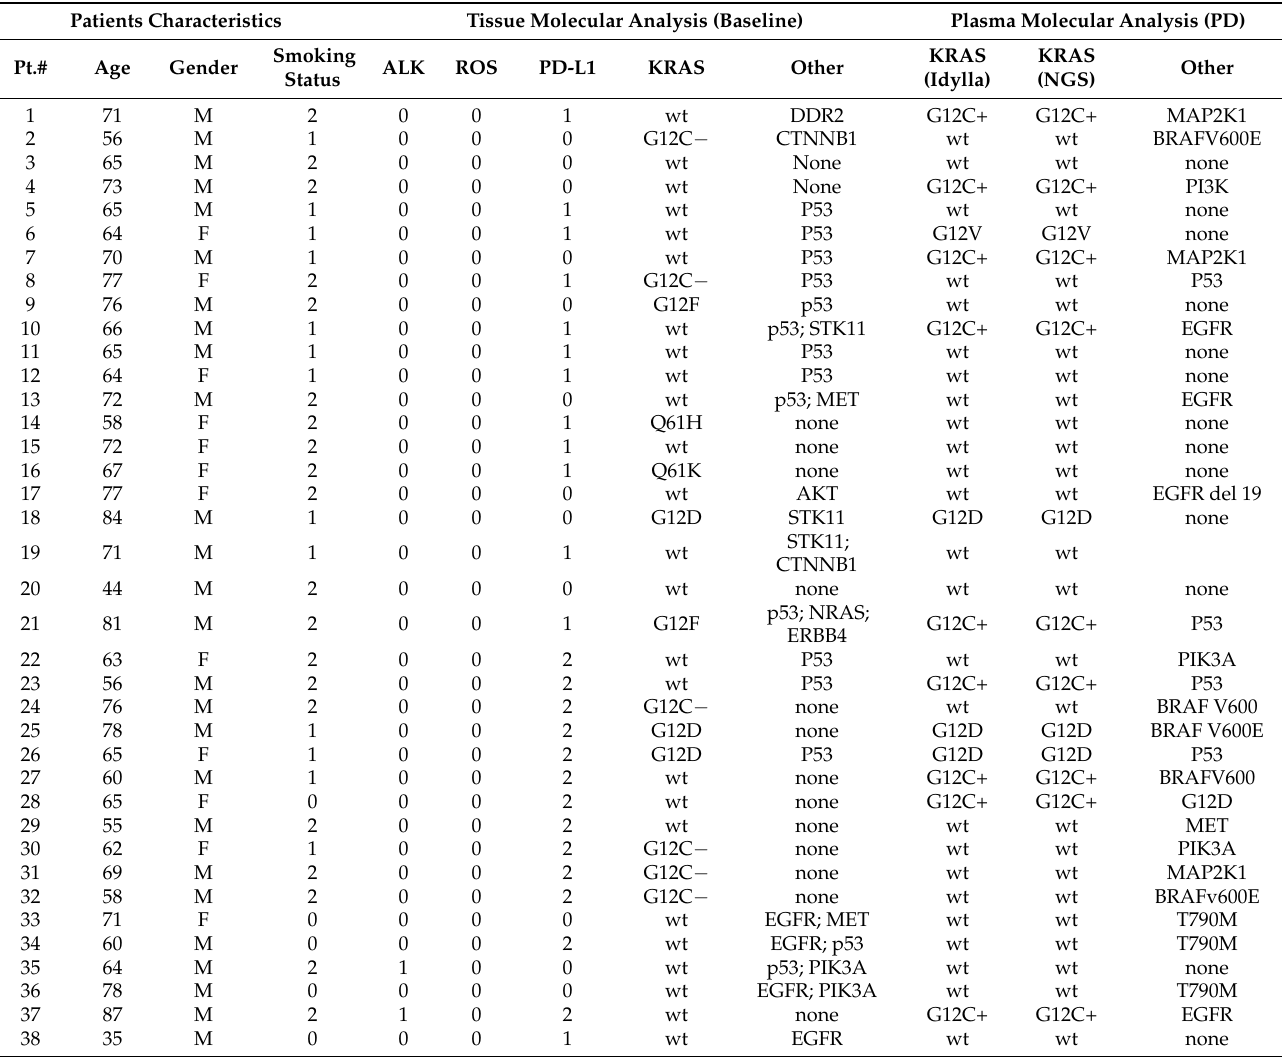
Table 1. Mutational analysis in the pretreatment tissue samples and in plasma ctDNA at disease progression.